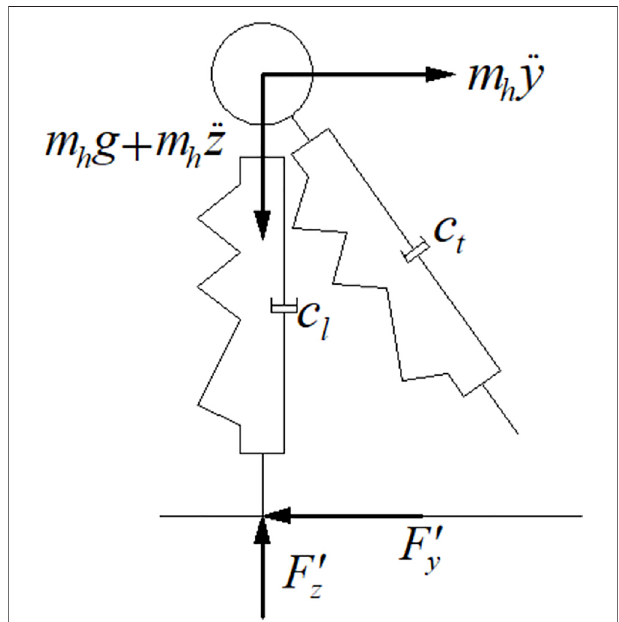
FIGURE 3 | Mechanical